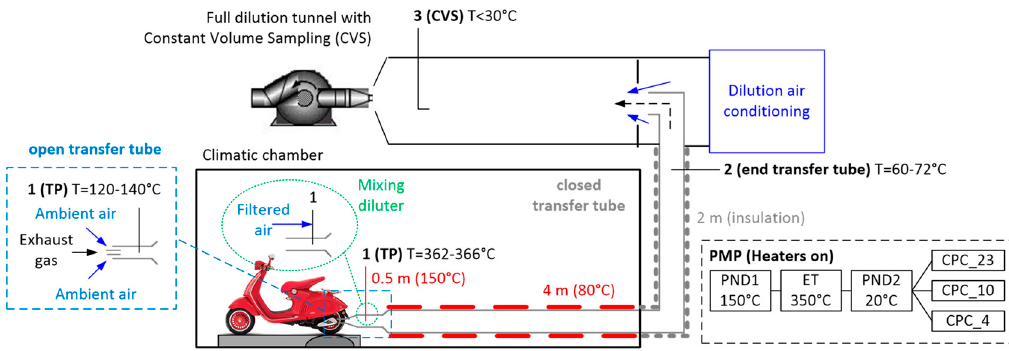
Figure 1. Experimental setup with two PMP systems at position 1 (PMP #1) and 2 or 3 (PMP #2). Exhaust gas temperatures at the different positions are also given. Square inset plots the open transfer tube configuration. Oval inset plots the cold dilution TP configuration with a mixing diluter. CPC = Condensation particle counter; CVS = Constant volume sampling; ET = Evaporation tube; PMP = Particle Measurement Programme; PND = Diluter; TP = Tailpipe.